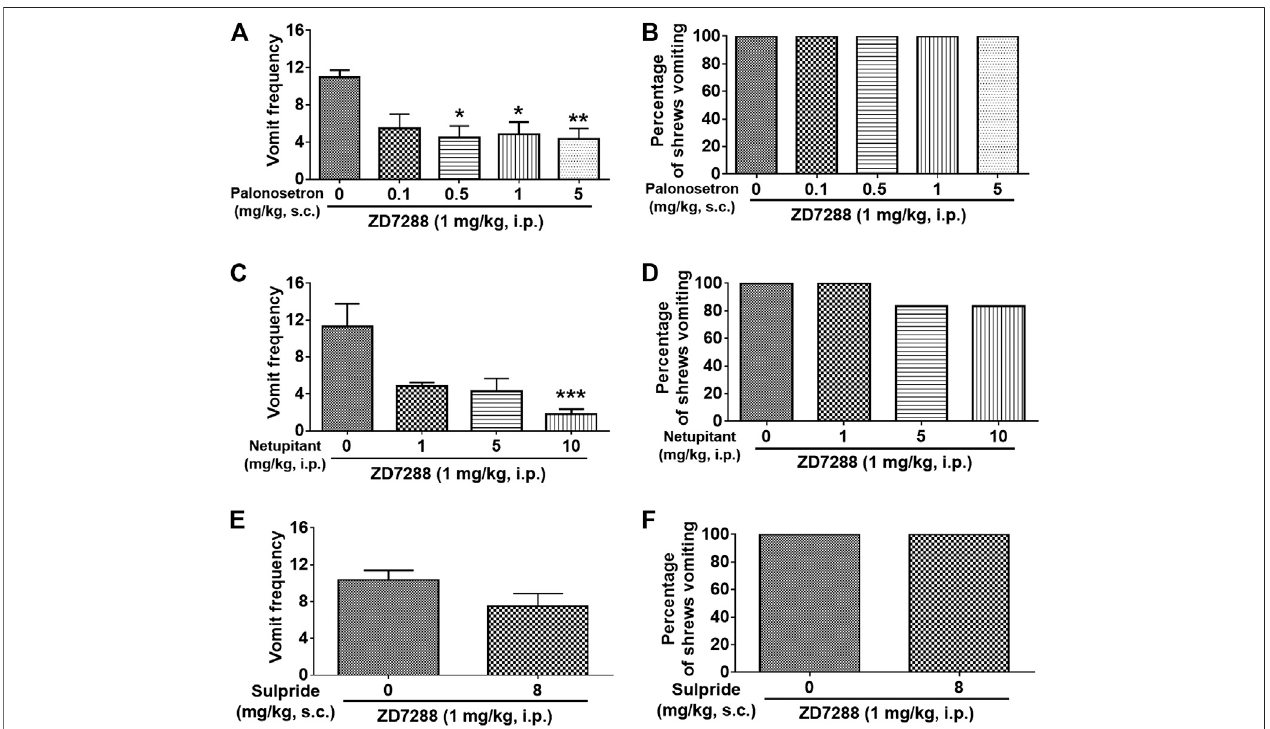
FIGURE 12 | Ef fi cacy of receptor-selective antiemetics against the HCN channel blocker ZD7288-induced emesis. Different groups of least shrews were given an injection of either the corresponding vehicles (0 mg/kg), or varying doses of 5-HT 3 R antagonist palonosetron (s.c.) ( n (cid:2) 6 shrews per group) (A and B), NK 1 R antagonist netupitant (i.p.) ( n (cid:2) 6) (C and D), or the D 2/3 R antagonist sulpride (s.c.) ( n (cid:2) 6) (E and F), 30 min prior to ZD7288 administration (1 mg/kg, i. p.). Emetic parameters were recorded for the next 30 min (A, C) The frequency of emesis was analyzed with Kruskal-Wallis non-parametric one-way ANOVA followed by Dunnett ’ s post hoc test and presented as mean ± SEM. (E) The frequency of emesis was analyzed with Unpaired t -test and presented as mean ± SEM. (B, D, F) Percentage of shrews vomiting was analyzed with chi-square test and presented as mean. * p < 0.05, ** p < 0.01, *** p < 0.001 vs. 0 mg/kg.